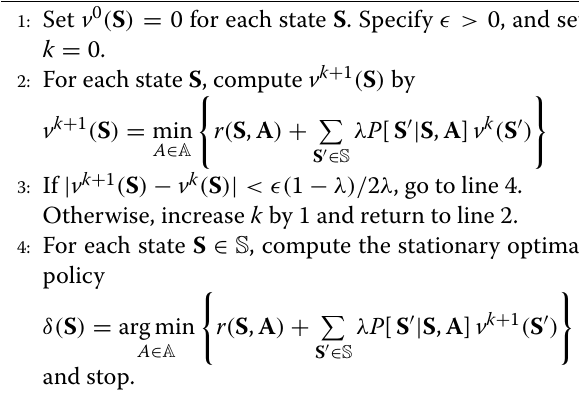
Algorithm 1 Value iteration